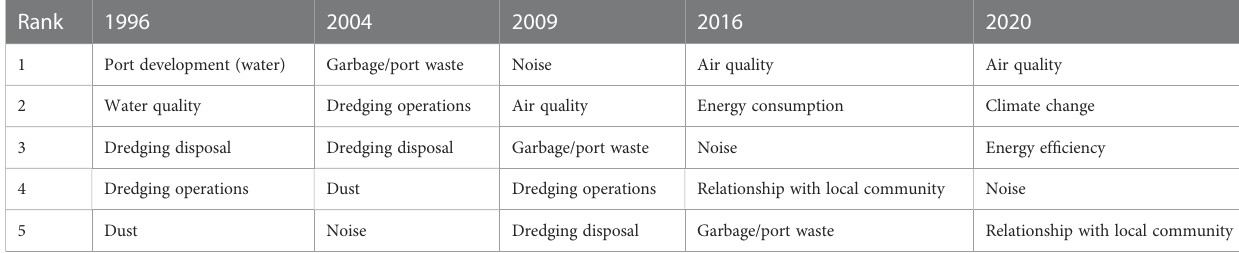
TABLE 3 Top Five Priorities in Ports Surveyed by ESPO